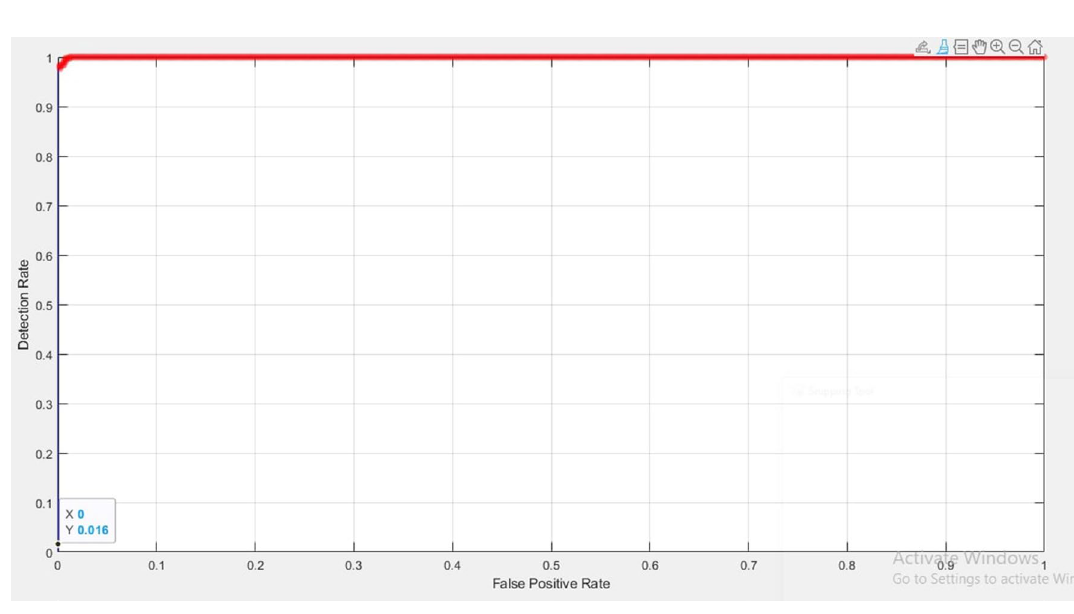
Figure 5. ROC curve of